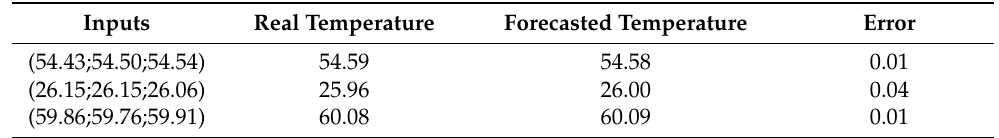
Table 1. Temperature forecast testing.